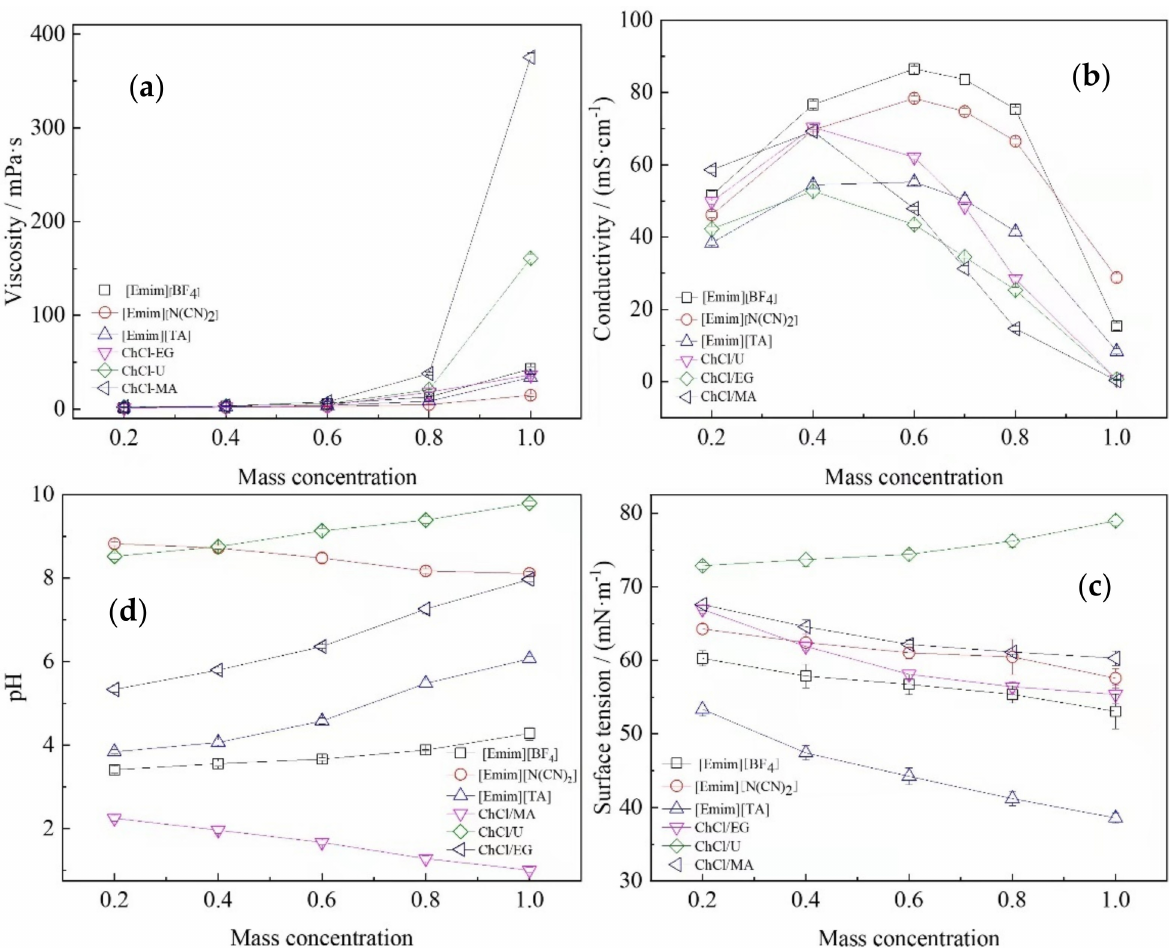
Figure 1. Physicochemical properties of the solvents with different concentrations: ( a ) viscosity; ( b ) conductivity; ( c ) surface tension; ( d )